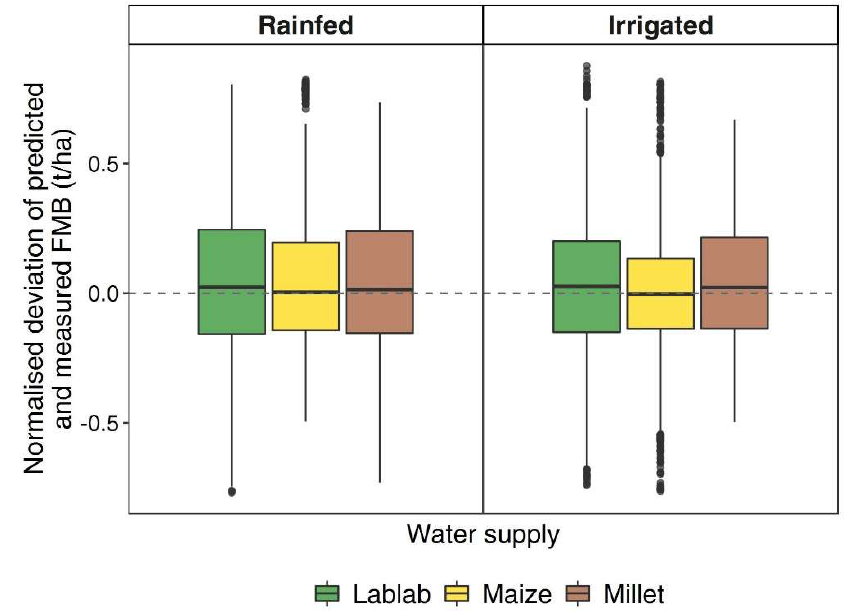
Figure 9. Normalised deviation between predicted and measured biomass for lablab, maize and finger millet at two levels of water supply (rainfed and irrigated). Predictions were based on the Generalised model. Values were averaged over 11 sampling dates (2016–2018) and two levels of water supply (i.e., rainfed and irrigated).